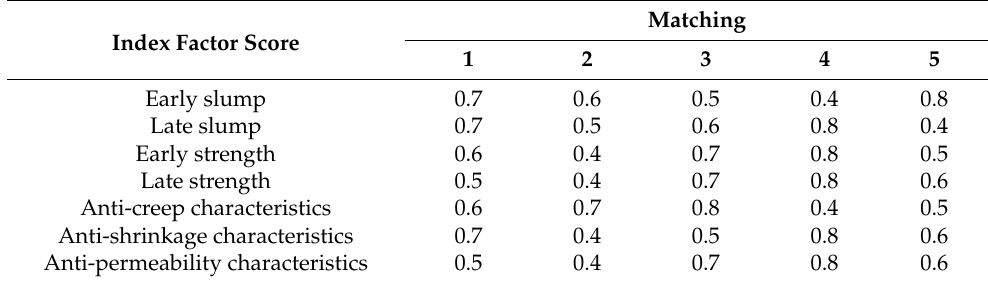
Table 7. Summary of scores of each evaluation